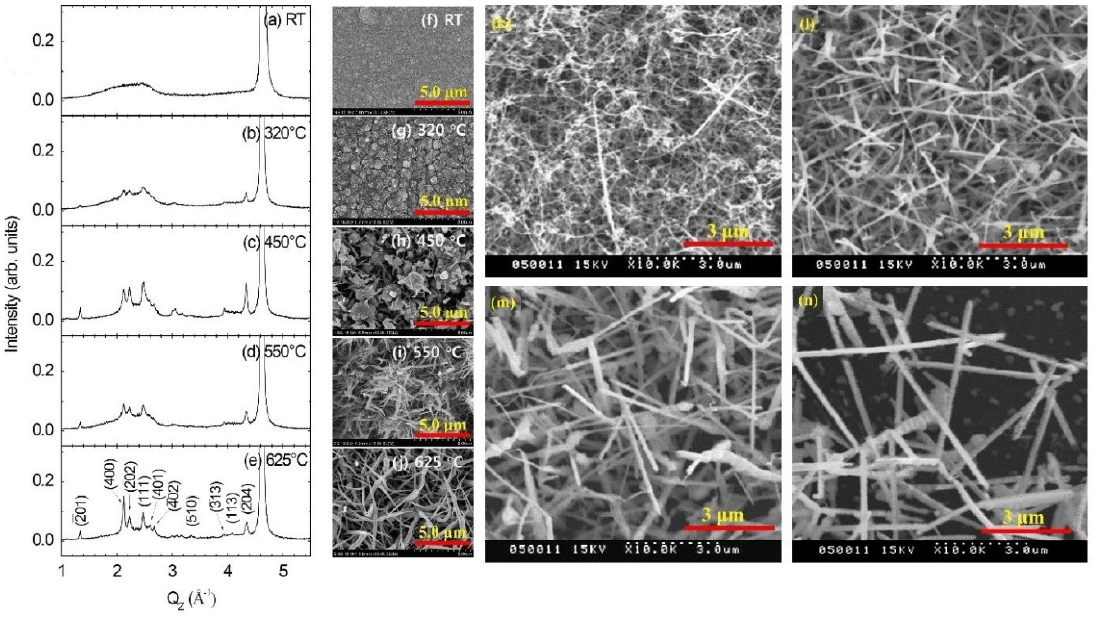
Figure 5. ( a – j ) XRD profiles along with the SEM images of the samples prepared by Lee et al., based on different substrate temperatures on SiN substrate. ( k – n ) the SEM images for the annealed samples [100]. “Reprinted with permission from Ref. [100]. Copyright (2011), Elsevier”. [101] “Reprinted with permission from Ref. [101]. Copyright (2015), Elsevier”. Table 2. Nanostructures of beta gallium oxide based on various parameters of magnetron sputtering.